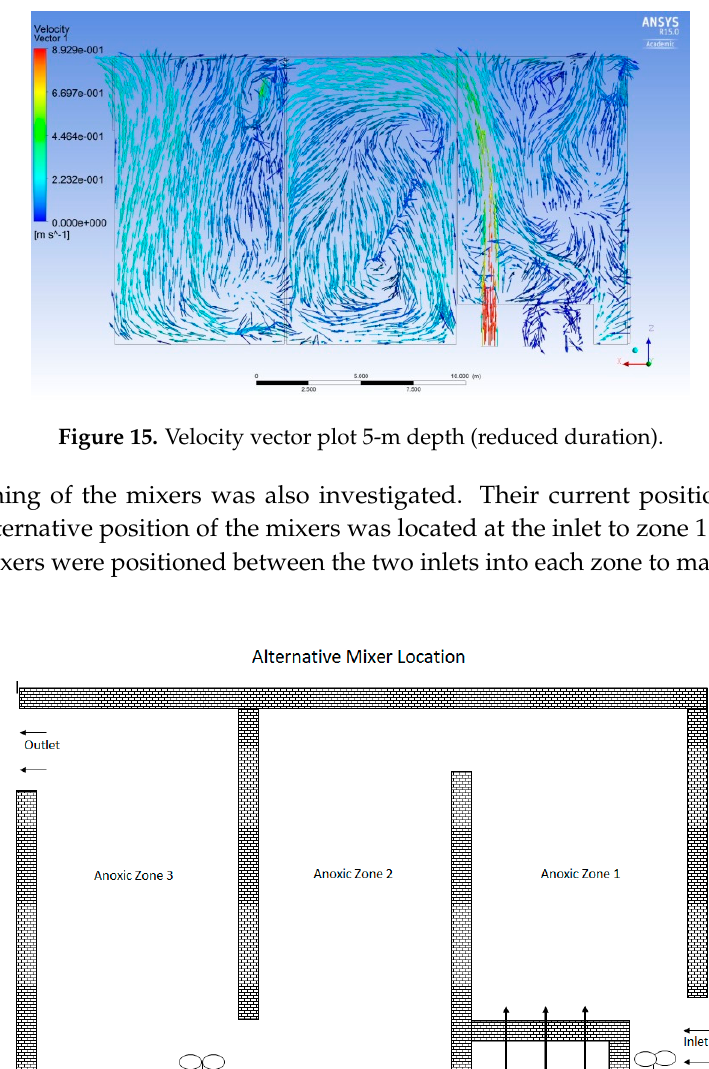
Figure 16. Alternative mixer positions.